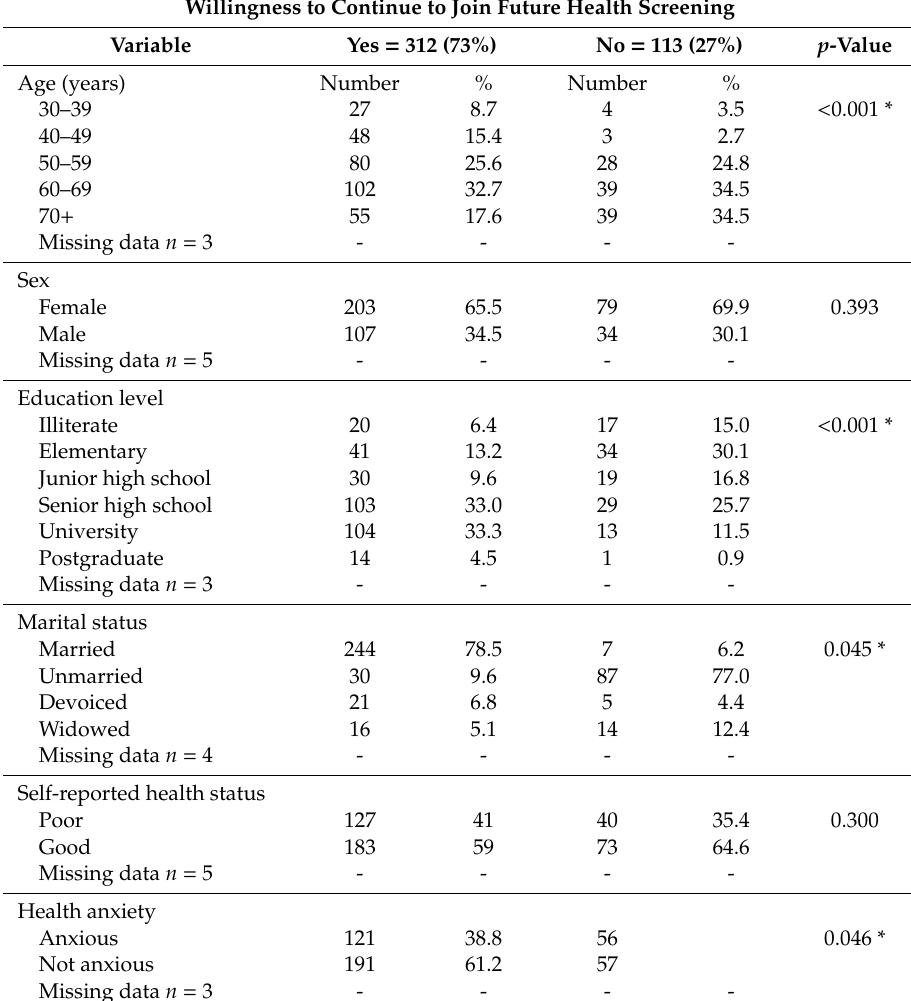
Table 2. Socio-demographic characteristics of study participants ( N =